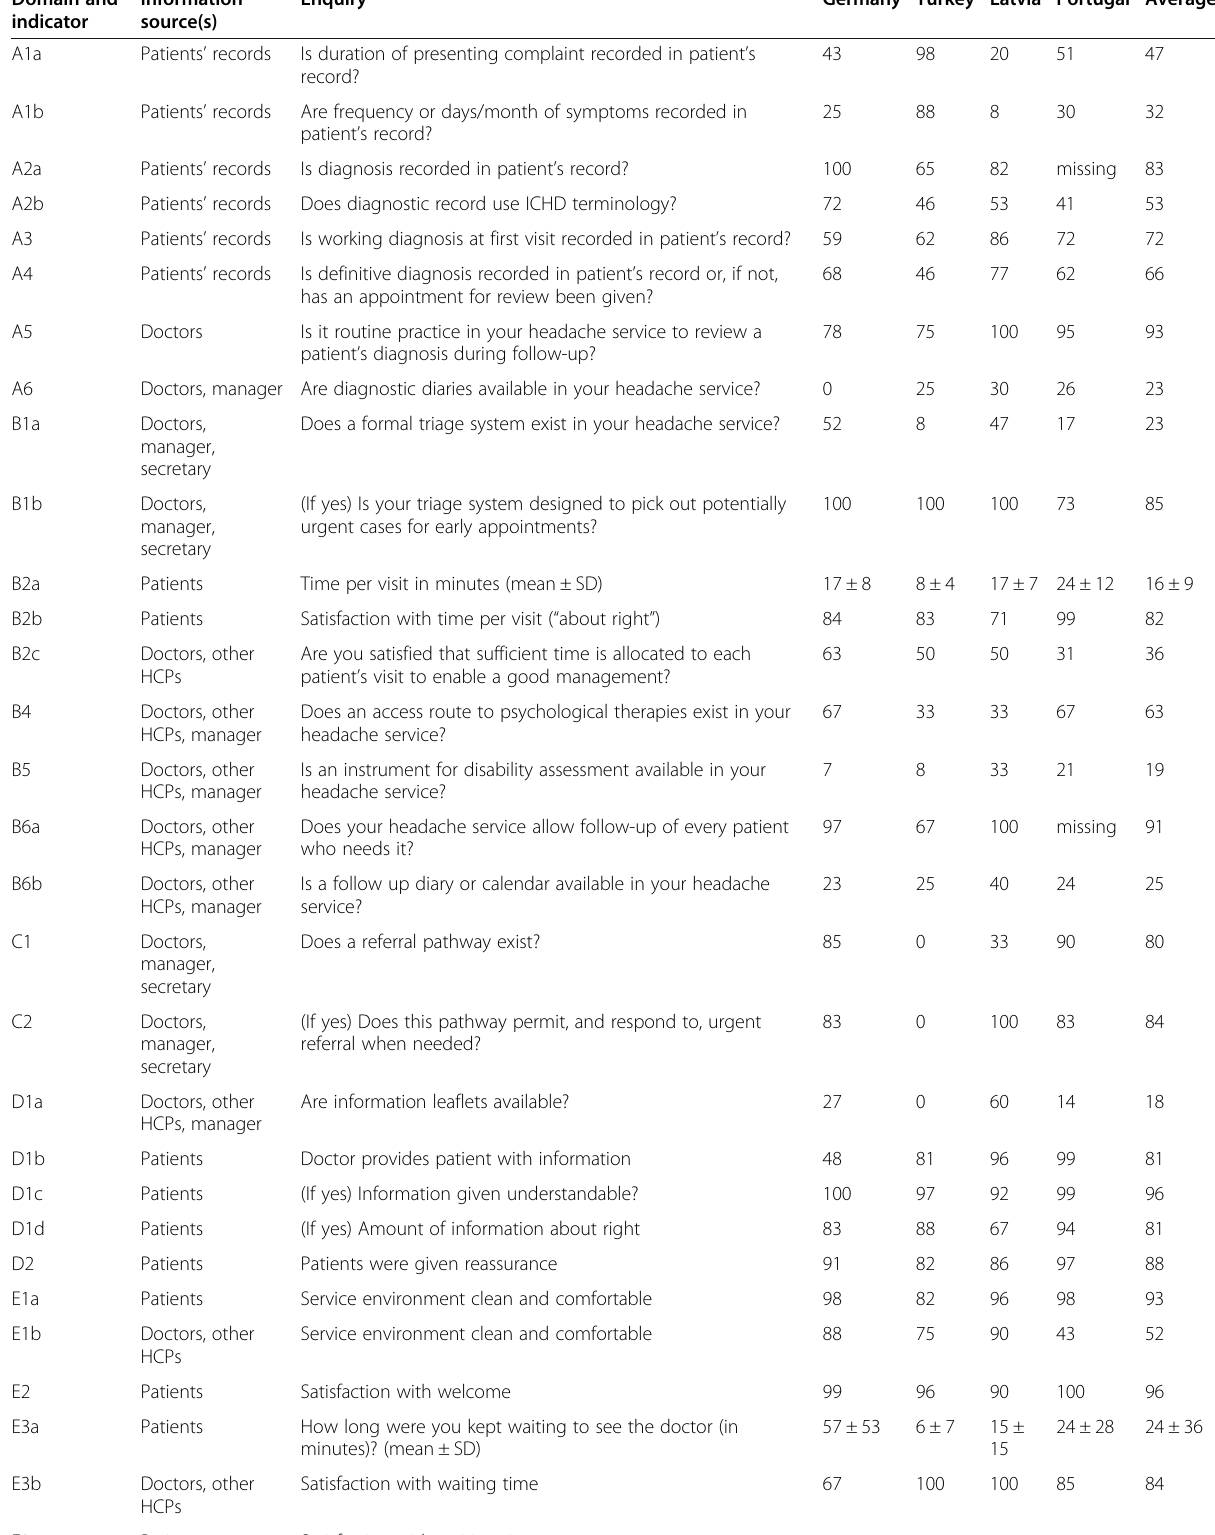
Table 3 Responses to questionnaire enquiries (% of positive answers, except where specified) Domain and